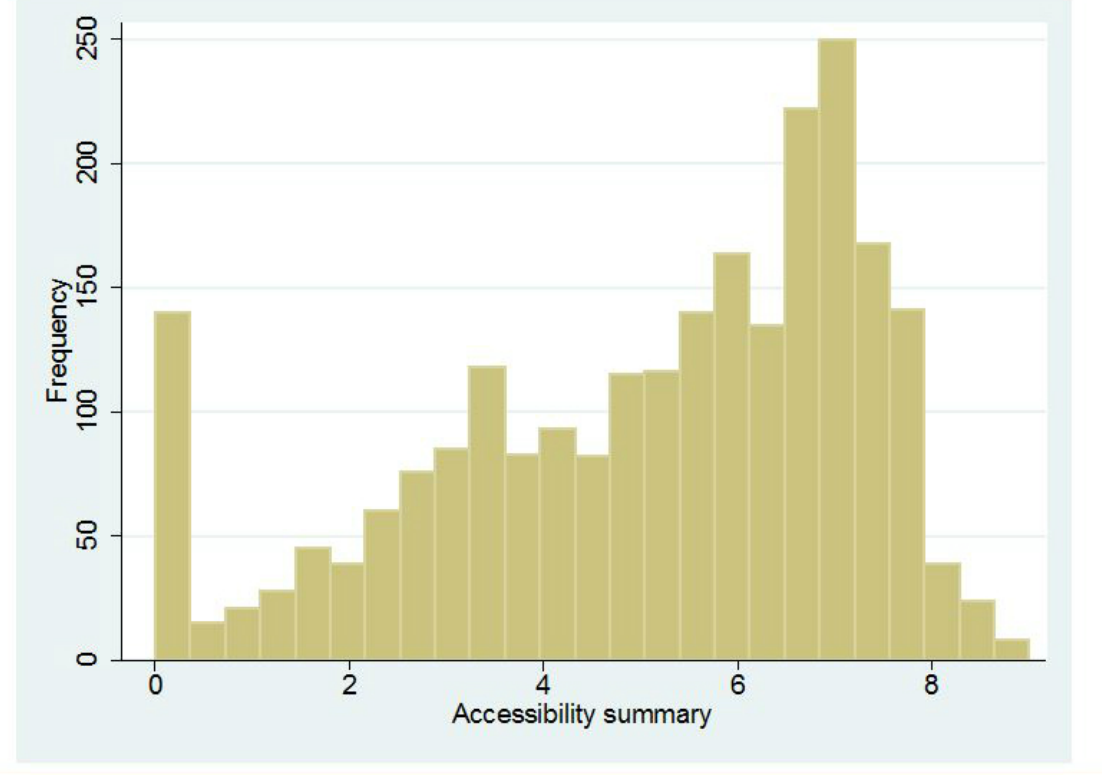
Figure 1. Distribution of scores: